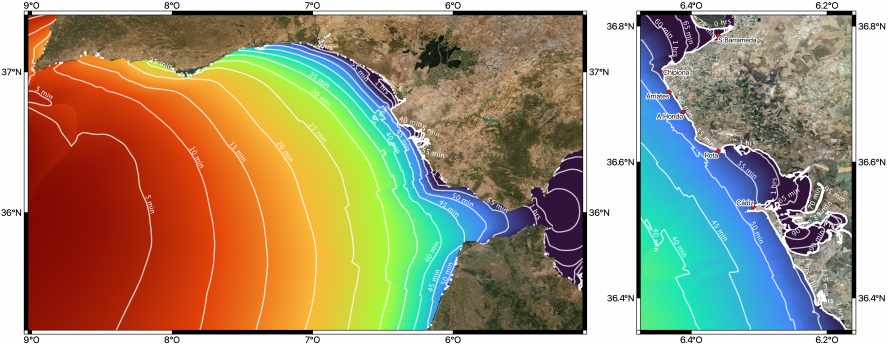
Figure 7. Arrival times split by minutes for the reference event. The spatial resolutions are 320 m ( left ) and 40 m ( right ).